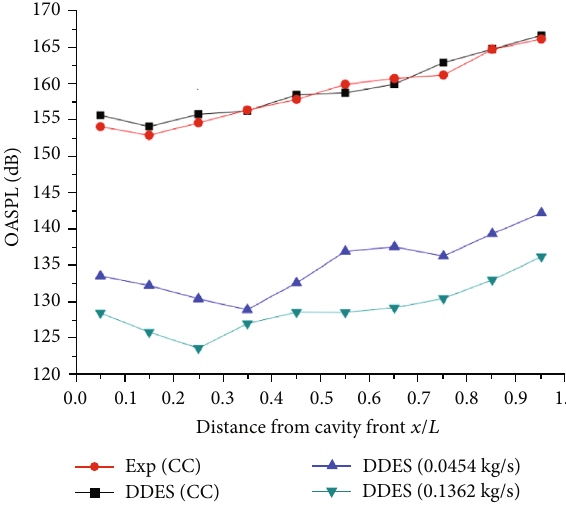
Figure 6: OASPL of active control cases.